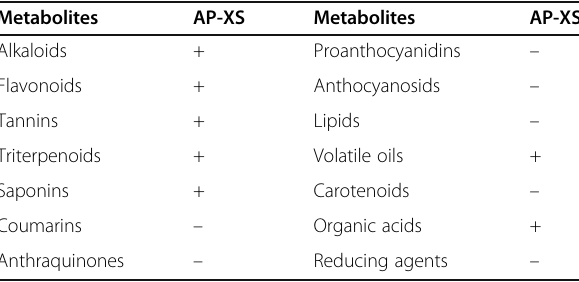
Table 1 Preliminary phytochemical screening results of AP-XS via chemical reactions